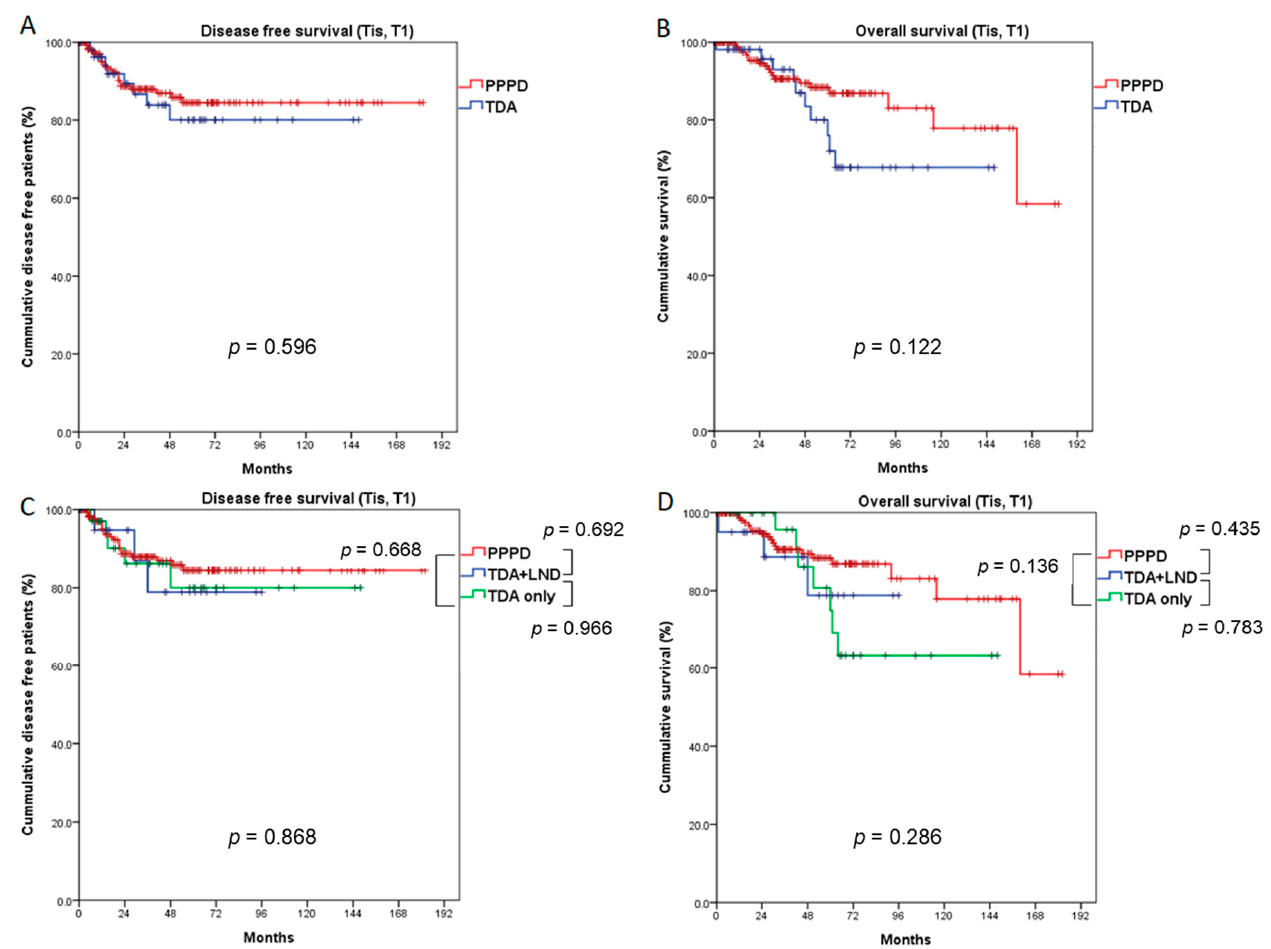
Figure 3. Comparison of survival outcomes between the PPPD and TDA groups (Tis and T1 patients). Five-year disease-free survival ( A ) and overall survival ( B ) did not differ between the PPPD and TDA groups. When the TDA group was divided into TDA + LND and TDA-only groups, the 5-year disease-free survival ( C ) and overall survival ( D ) did not differ among the three groups. LND: lymph node dissection.